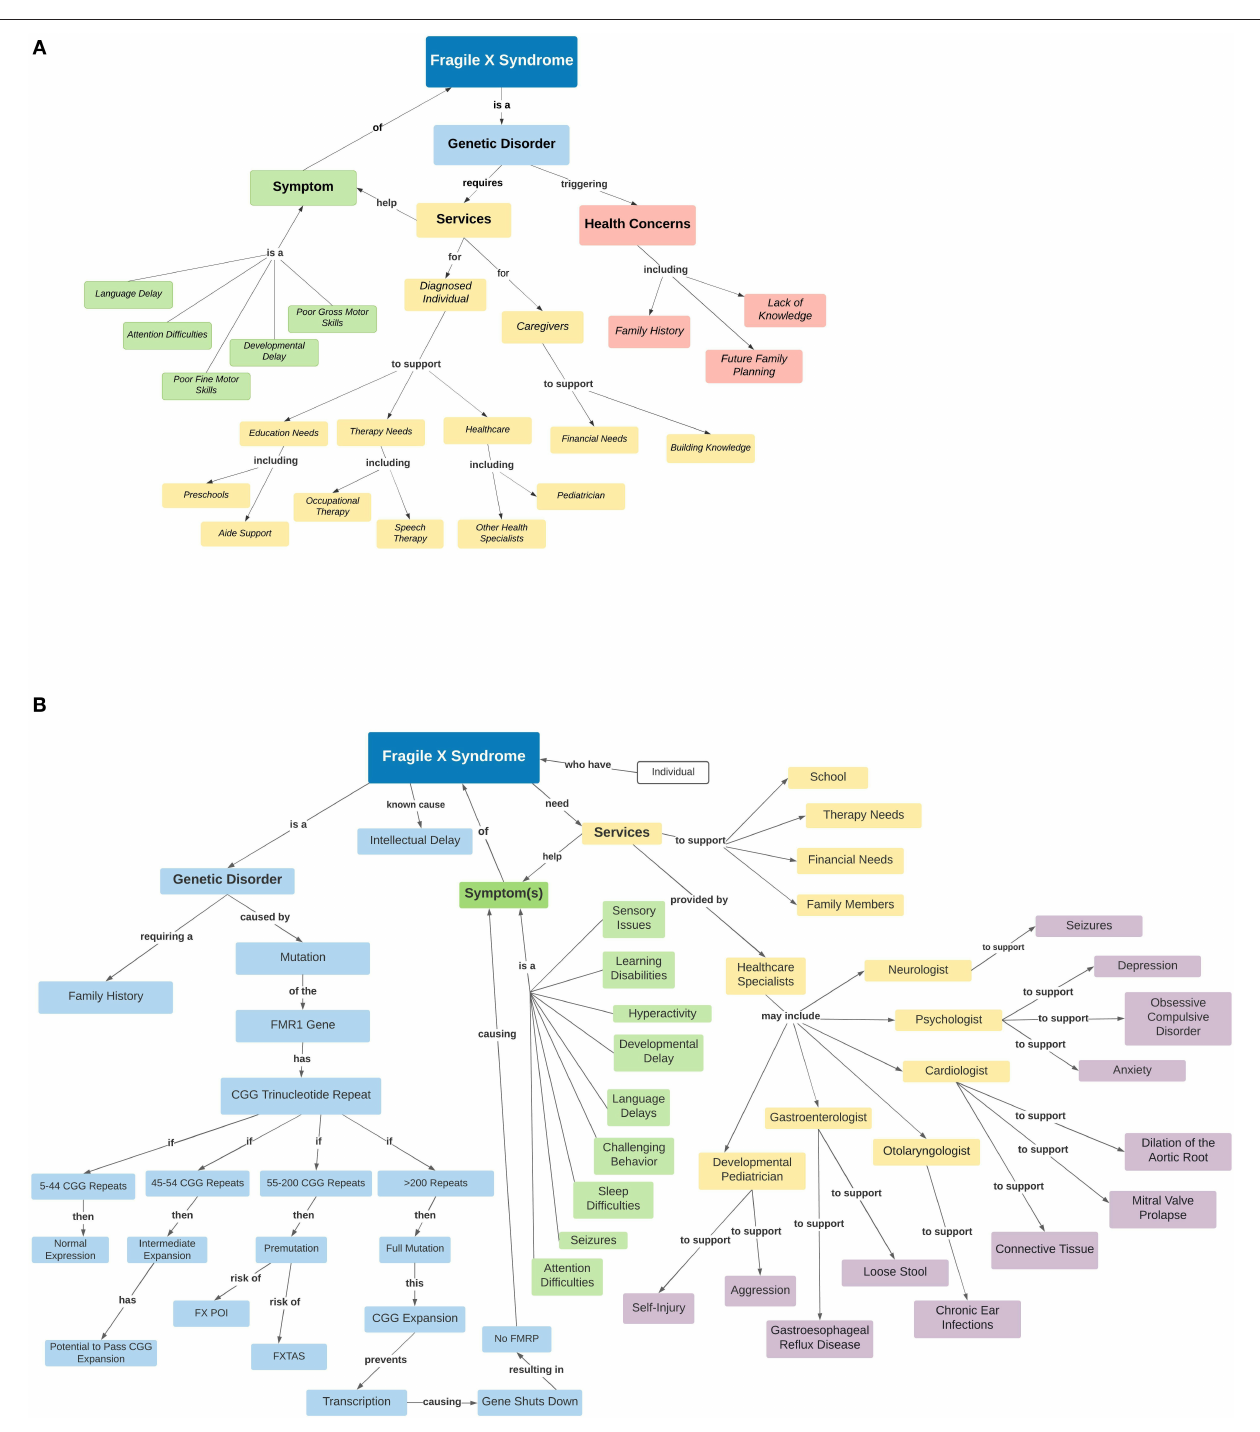
FIGURE 1 | Mental models vary between caregivers and healthcare professionals supporting individuals living with FXS. Concept maps representing the mental models of Fragile X syndrome symptoms and associated conditions (comorbidities) from a caregiver’s perspective (A) and a healthcare professional’s perspective (B) . This visual representation shows how mental models of FXS can vary between caregivers and health professionals, and may overlap in others (healthcare for instance). (A) The mental model of a caregiver may include concepts related to personal concerns outside of healthcare and a general understanding of the health system. (B) On the other hand, the mental model of a healthcare professional may only focus on the concepts related to healthcare more specifically, with a bias toward the consideration of their specialty. Legend of abbreviations used in the figure: FMR1, Fragile X mental retardation 1 gene; FXPOI, Fragile x Premature ovarian insufficiency; FXTAS, Fragile X tremor and ataxia